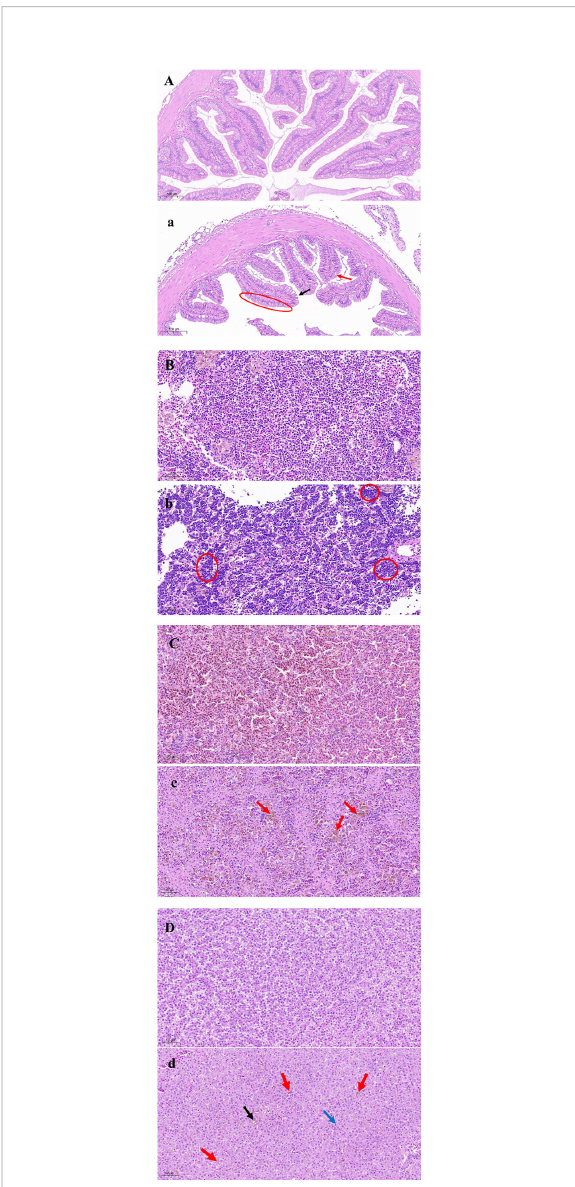
FIGURE 6 Histological changes in largemouth bass challenged by the XX2021 strain. (A-D) are the intestines, head kidney, spleen, and liver of a healthy fi sh, respectively; (a) Goblet cell absence (black arrow), epithelium vacuolization (red arrow), and cell degeneration and vagueness of the cuticula (the area circled in red) in the intestine. (b) Head kidney in fi ltrated by numerous in fl ammatory cells (the area circled in red). (c) Abundant hemosiderin granules (red arrows) in the spleen. (d) Serious vacuolization of cells (black arrow), clearly pyknotic nuclei (blue arrow), and an increased number of Kupffer cells (red arrows) in the